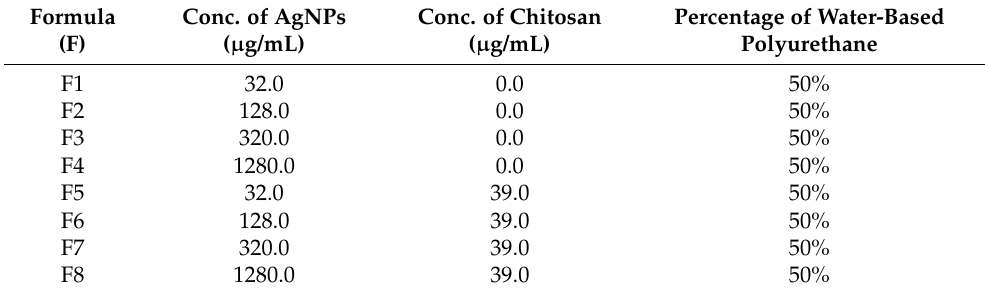
Table 1. Formulas of self-disinfection coating developed based on antibacterial activity testing